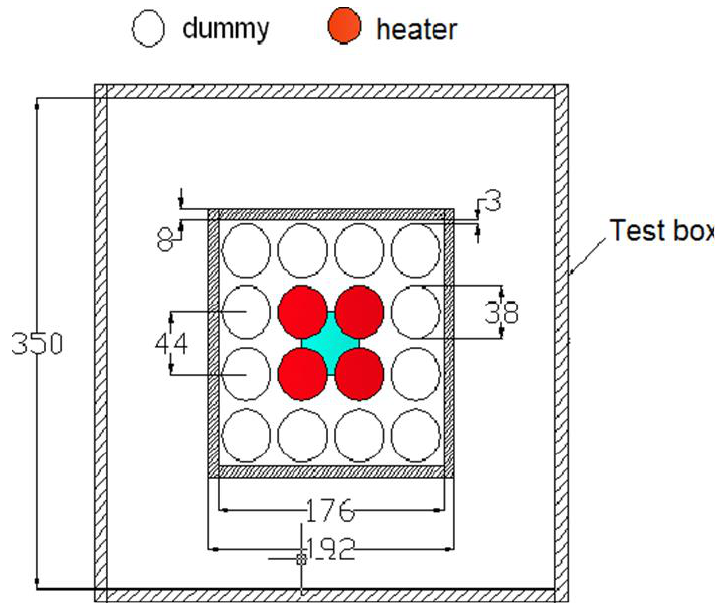
Figure 2. Horizontal cross-section of simulation test.